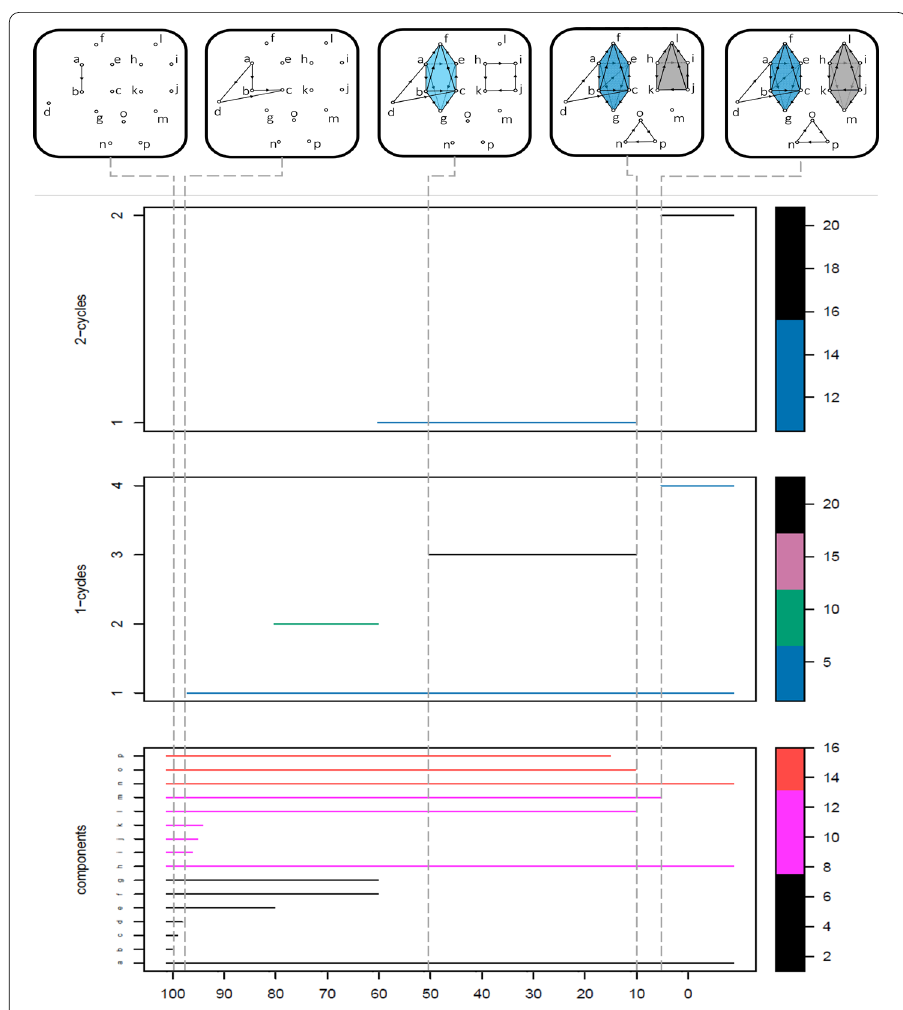
Figure 7 Barcodes for the toy example. Colored persistence barcodes for the toy network in Fig. 6 superimposed with several slices in the filtration. For this example, the original edge weights are used as labels (instead of the transformed values) for threshold levels. The colored 0-dimensional barcode (bottom) reflects which connected component each vertex eventually belongs to. The colored 1 and 2-dimensional barcodes (middle and top respectively) distinguish the 1-cyles and 2-cycles by three criteria: persistence, perpetuity, and weights